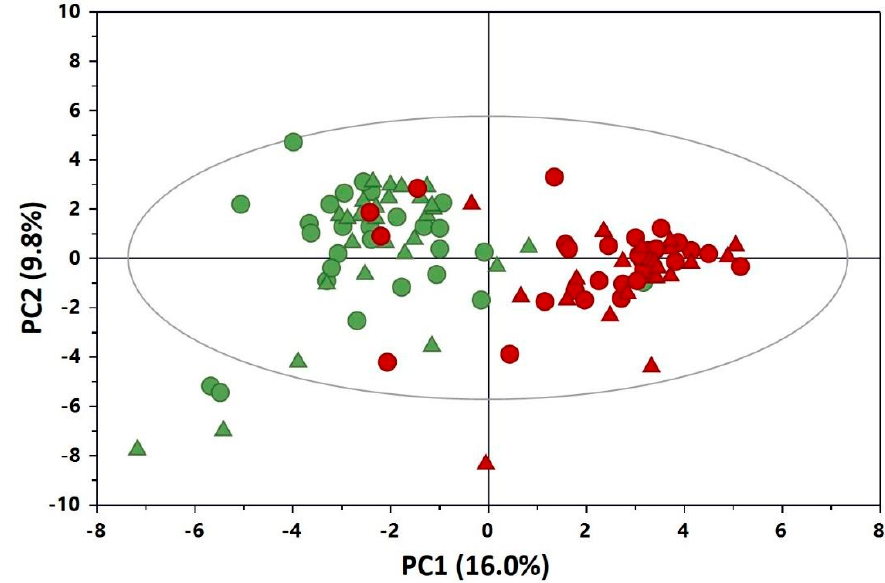
Figure 1. Principal component (PC) 1 vs. PC2 scores plot of the principal component analysis (PCA) model derived from the 1 H NMR spectra of urine collected from preterm infants before (green, T0) and at 21 days (red, T1) of adjustable (ADJ) fortification (R 2 X = 0.259; Q 2 = 0.162): • , B-HMF (infants receiving commercial multicomponent fortifier and protein concentrate derived from bovine milk); ▲ , D-HMF (infants receiving experimental multicomponent fortifier and protein concentrates derived from donkey milk).